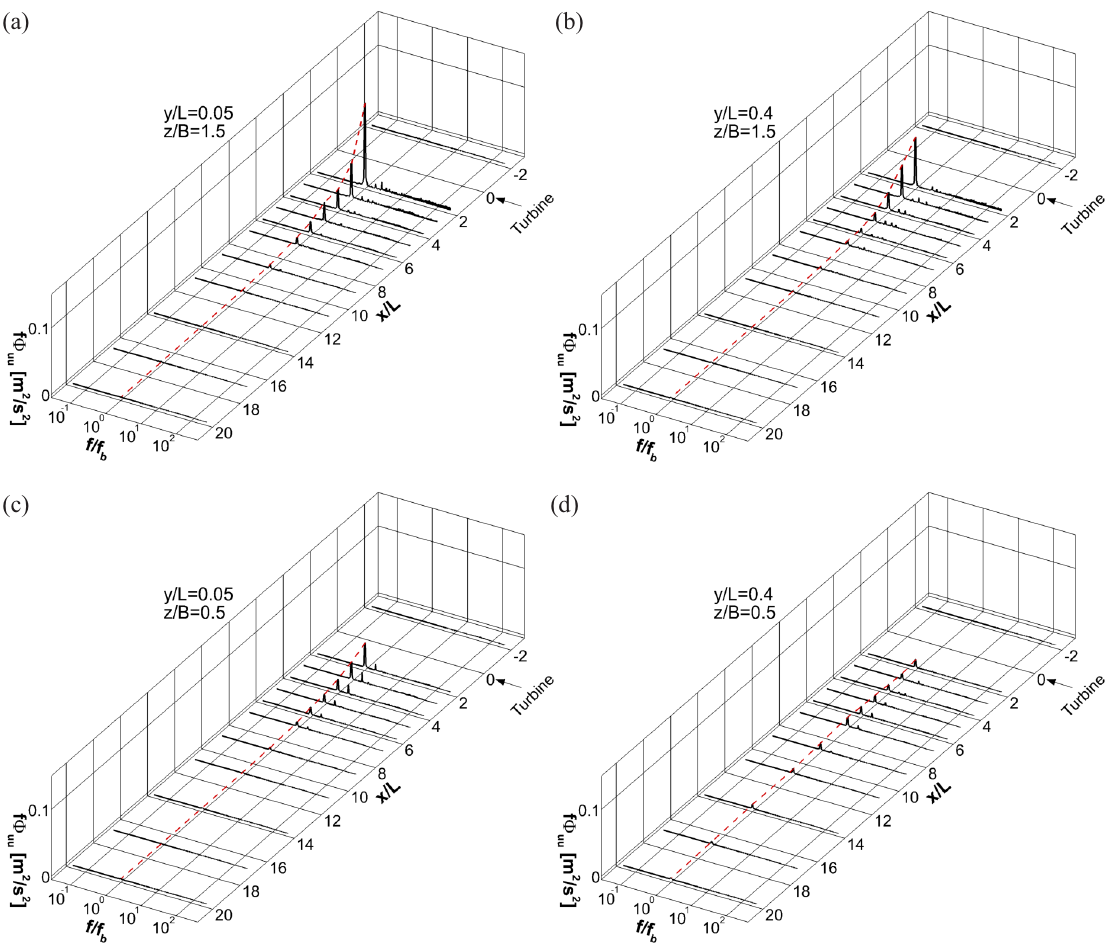
Figure 10. Premultiplied spectra of the u component ( a ) near the lateral wall and ( b ) the blade center at z / B = 1.5 (the blade center height) and ( c ) near the lateral wall and ( d ) the blade center at z / B = 0.5 (the midpoint between the bottom edge of the blade and the channel bed).